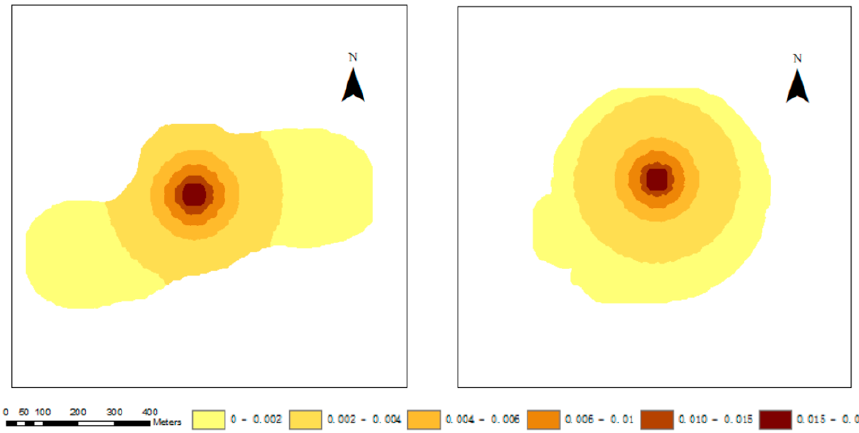
Figure 9. Probabilities distribution of individuals A and B.